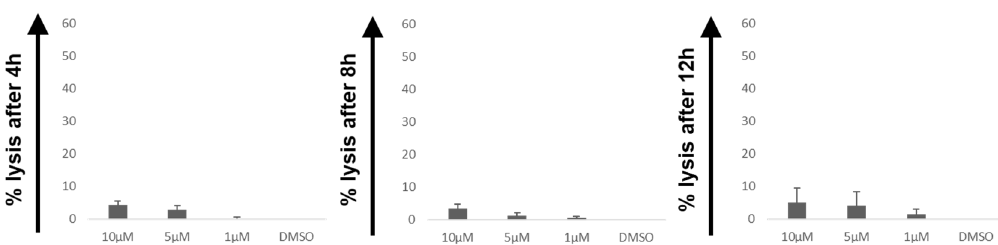
Figure 2. Direct lysis of Daudi cells by PipFcB. Cytotoxicity of PipFcB alone without CARTs was determined by 51 Cr release assay after co-culture with Daudi cells for 4 h, 8 h, and 12 h. Different concentrations of the specific ROS accelerator PipFcB (10 µM, 5 µM, 1 µM) or DMSO (vehicle) were used. PipFcB as a monotherapy achieved only minimal lysis in the evaluated incubation times. All experiments were performed in triplicates and in three independent experiments. Mean values were calculated for each group; error bars indicate standard deviation.